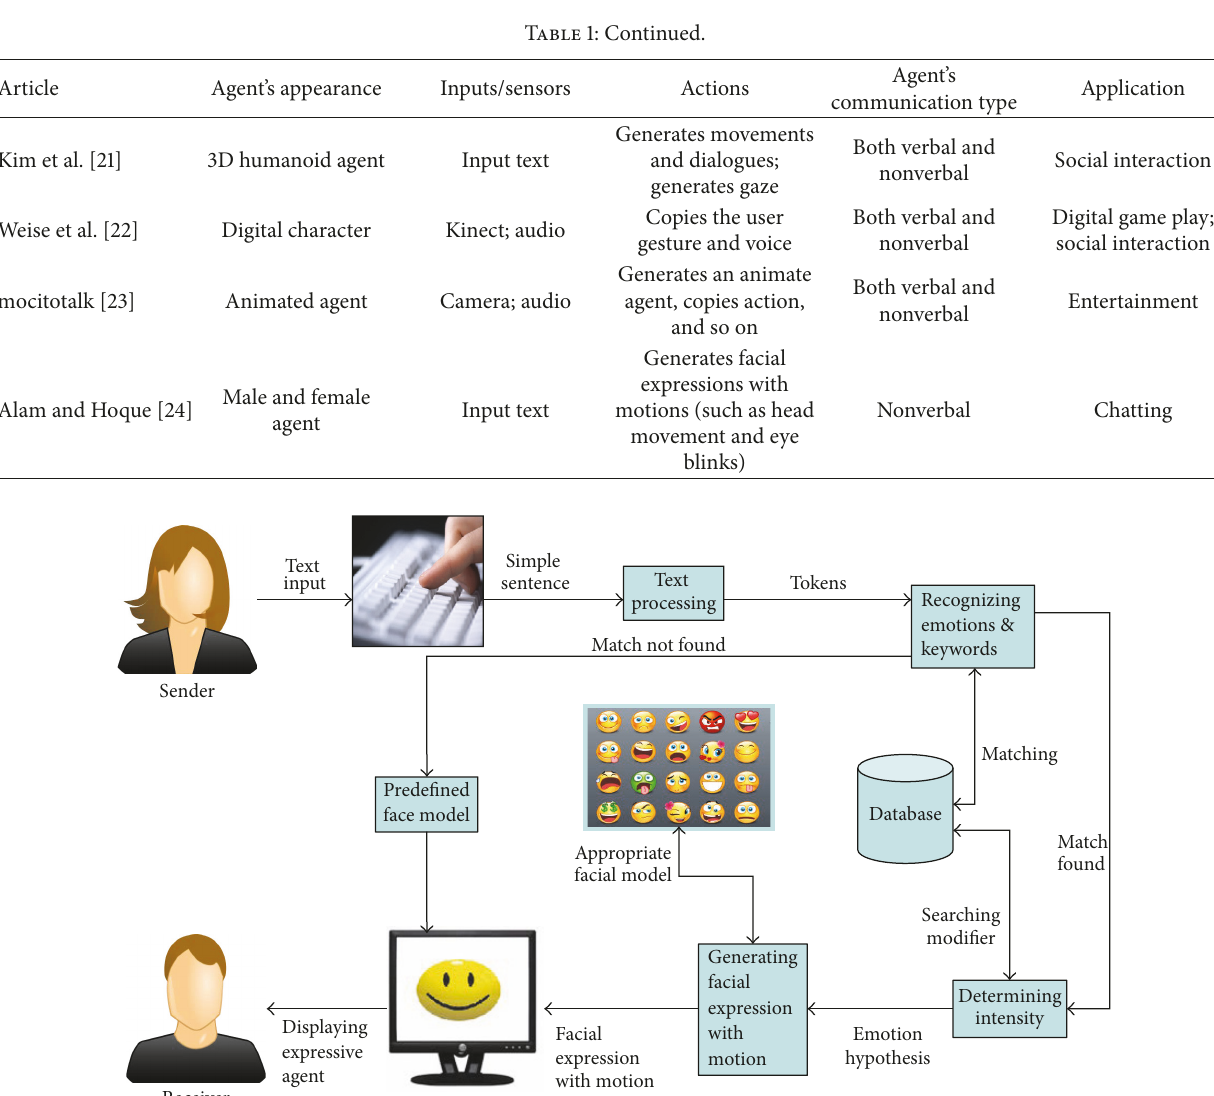
Figure 1: Proposed framework for the